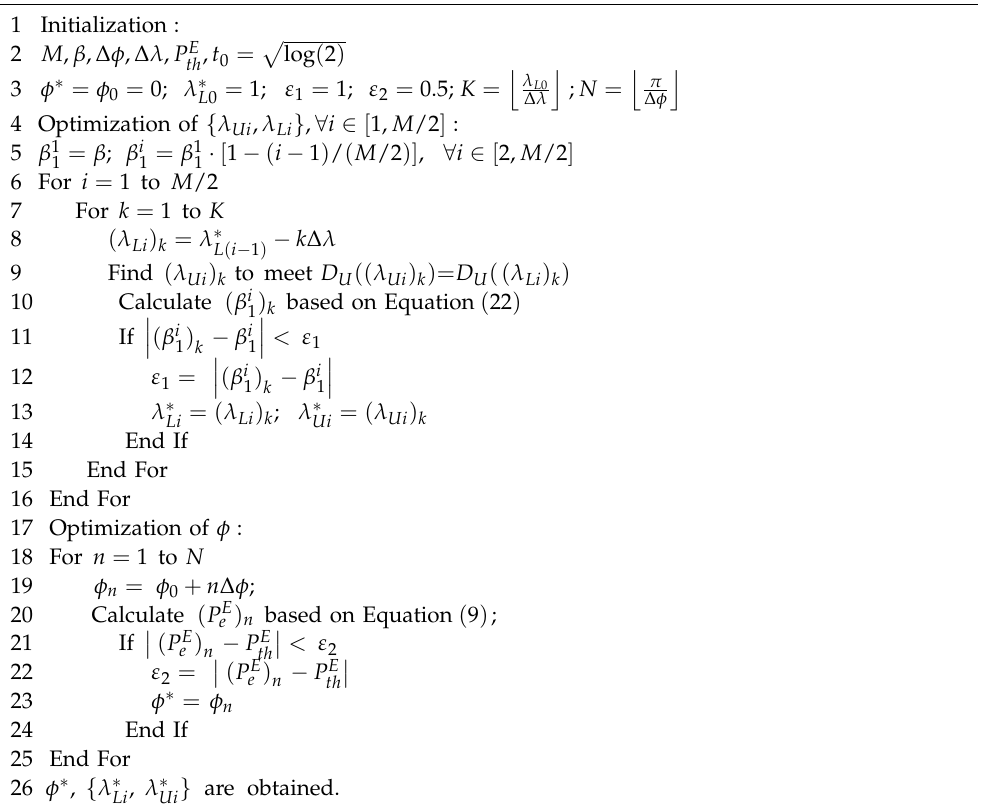
Algorithm 1: Optimization Algorithm of Key Parameters for Constellation-Rotating-Based Secure Decision Fusion under a Given Error Constraint of